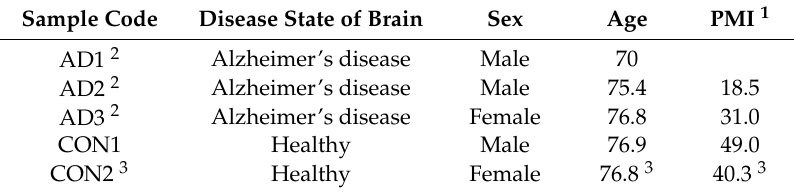
Table 3. Characteristics of donated specimens used in this